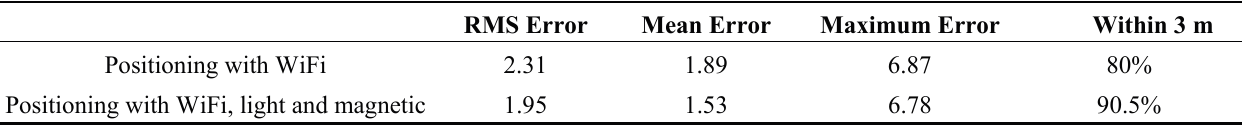
Table 2. The positioning error statistics